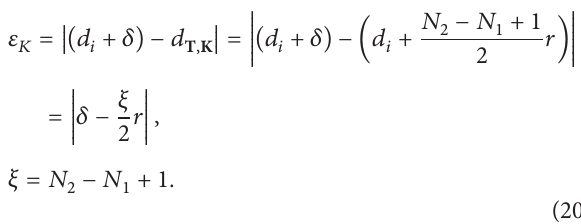
RADAR with one neighbor in Case 1, r = 1 m, 0.8 m and 0.6 m RADAR with one neighbor in Case 2, r = 1 m, 0.8 m and 0.6 m RADAR with one neighbor, r = 1 m, 0.8 m and 0.6 m Figure 3: Confidence probabilities by one-neighbor matching localization.